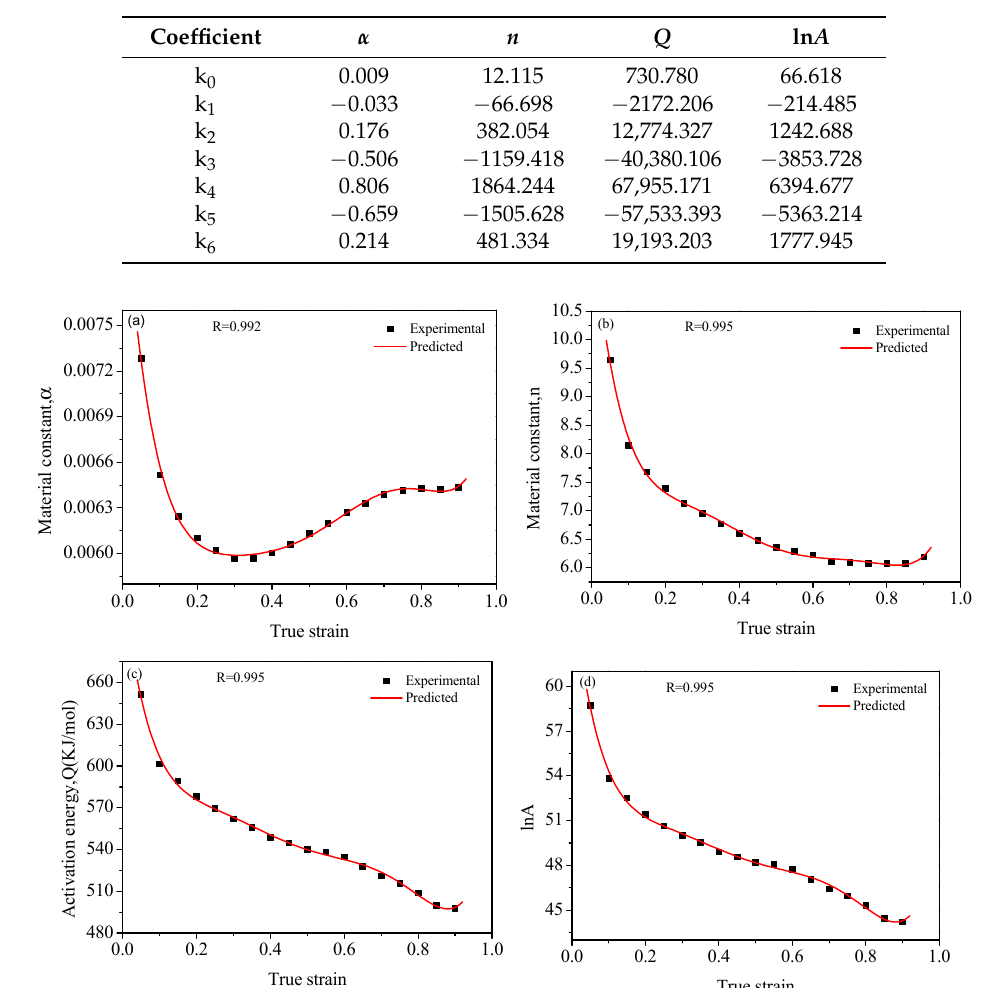
Table 4. Polynomial fitting results of a , n , Q and ln A for the H13-mod steel.